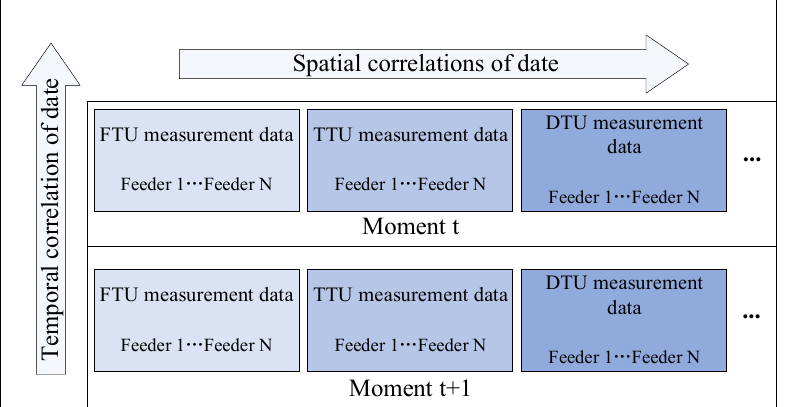
Figure 3. Temporal and spatial correlation of distribution network measurement data.